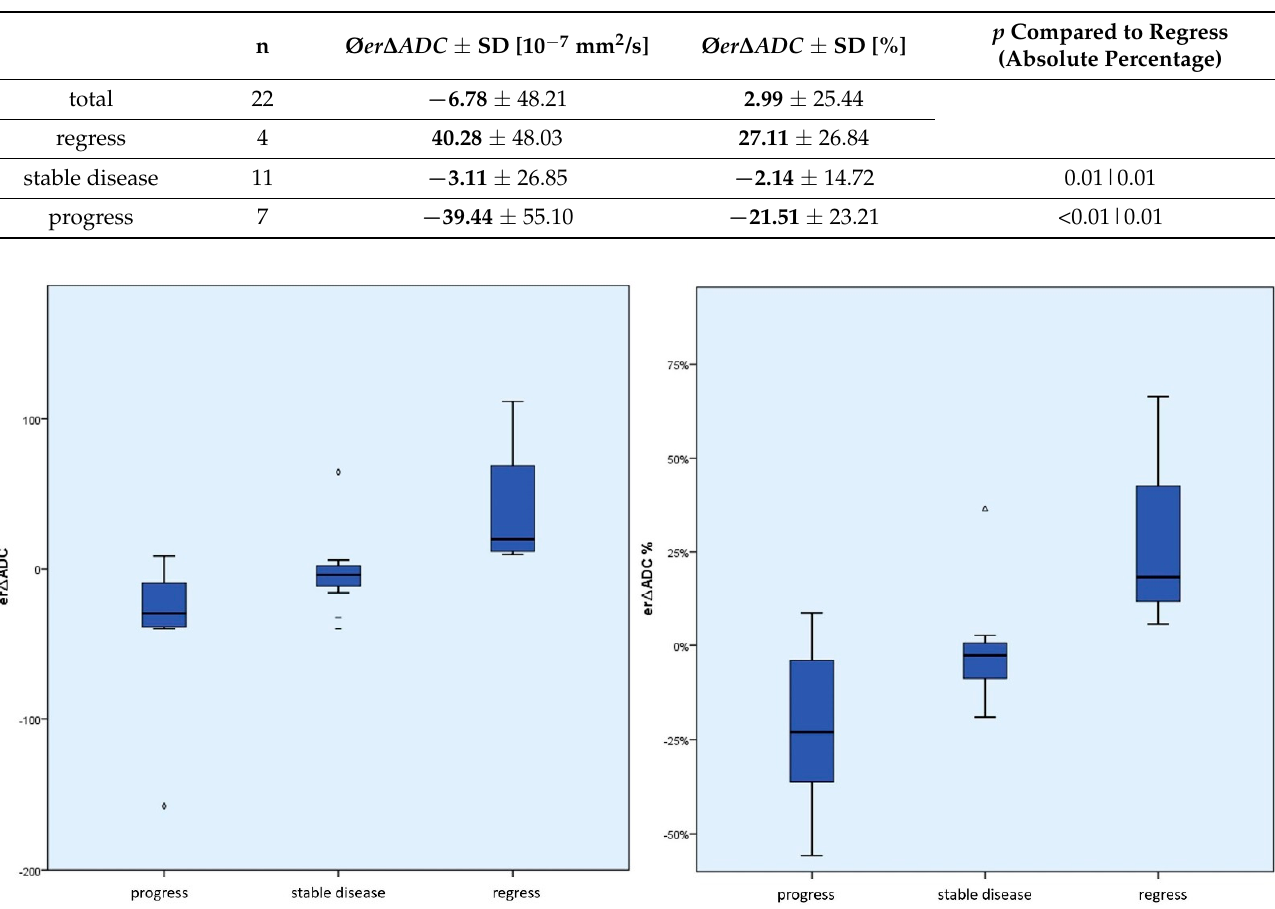
Table 4. Mean er ∆ ADC values (bold) in absolute and percentage terms based on the course of the disease. There was a significant absolute and relative ADC increase in the first 120 days after the start of therapy with tumor regression compared to stable disease and compared to progress (absolute p = 0.01 or <0.01, percentage p = 0.01).